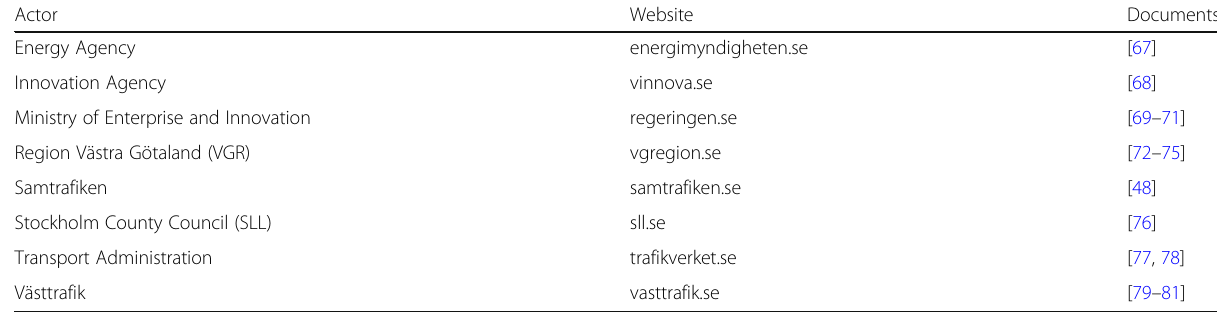
Table 2 Documents and websites reviewed in the Swedish Case